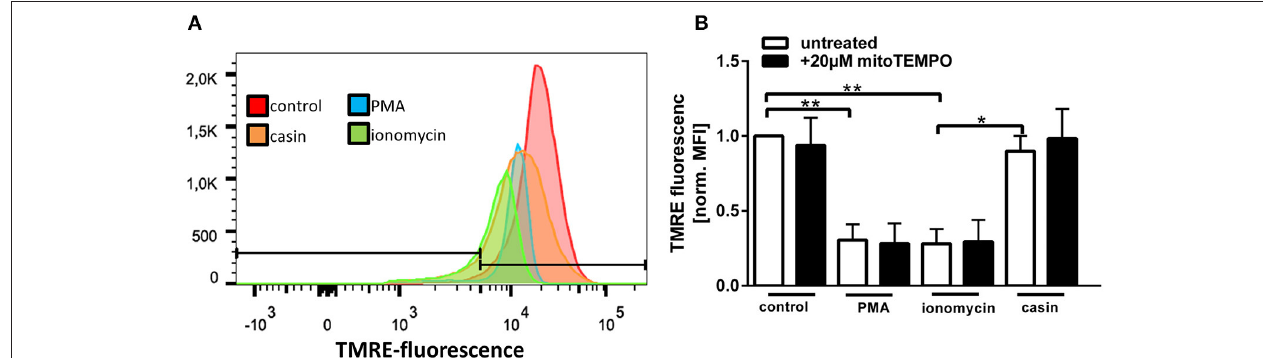
FIGURE 4 | Cdc42 inhibition does not change the mitochondrial membrane potential. Freshly isolated human neutrophils were pre-incubated with or without the mitochondrial ROS inhibitor mitoTEMPO (20 µ M) for 30min at 37 ◦ C. Subsequently, cells were left untreated (control) or treated for 1h with 20nM PMA, 10 µ M ionomycin or with the Cdc42 inhibitor casin (10 µ M) at 37 ◦ C. Neutrophils were incubated with the mitochondrial membrane potential indicator TMRE for 30min at 37 ◦ C followed by flow cytometry analysis. (A) Representative histogram of TMRE fluorescence. (B) Displayed is the mitochondrial membrane potential normalized to the value of control cells, in response to different stimuli with or without the inhibition of mitochondrial ROS. Data show mean ± SD of 3 independent experiments. ** p ≤ 0.01 and * p ≤